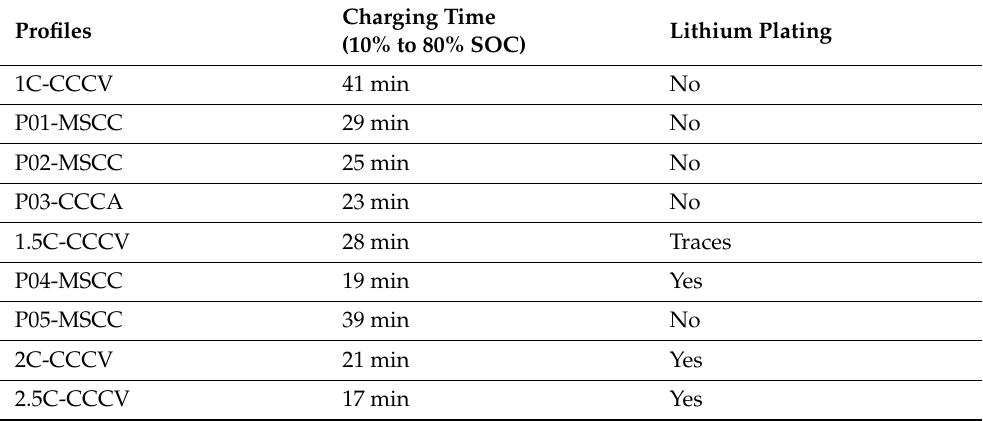
Table 1. Overview of applied fast-charging profiles; charging time for 10 to 80% SOC at a 25 ◦ C initial temperature; lithium plating detection based on several test methods. For details on lithium plating detection, see